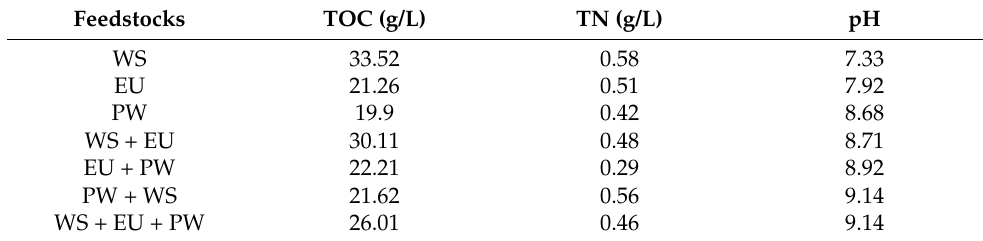
Table 5. Characterization of the aqueous